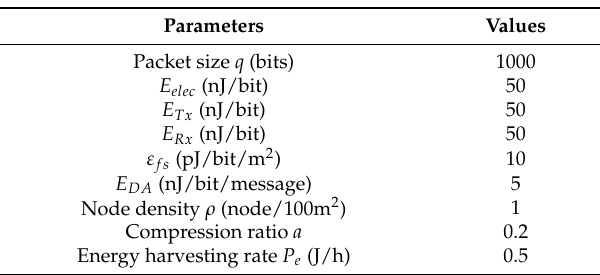
Table 2. Simulation